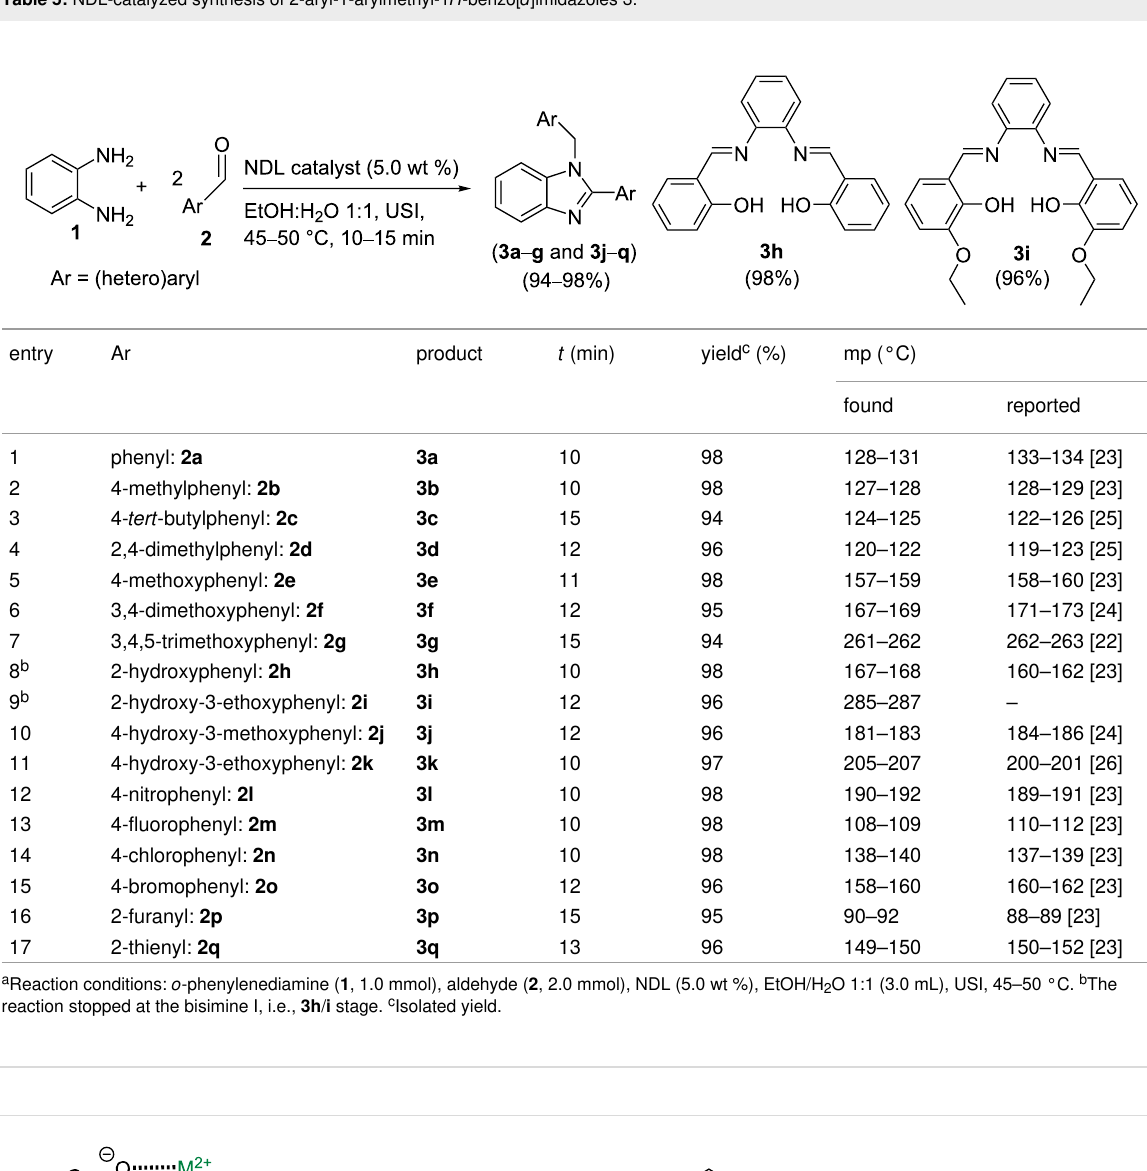
Table 5: NDL-catalyzed synthesis of 2-aryl-1-arylmethyl-1 H -benzo[ d ]imidazoles 3. a